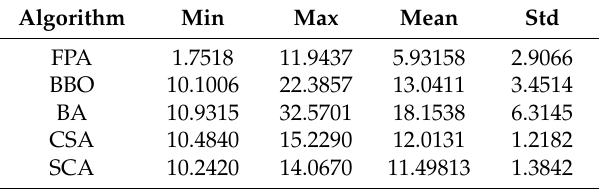
Table 2. Minimum function statistical data using different optimization algorithms.